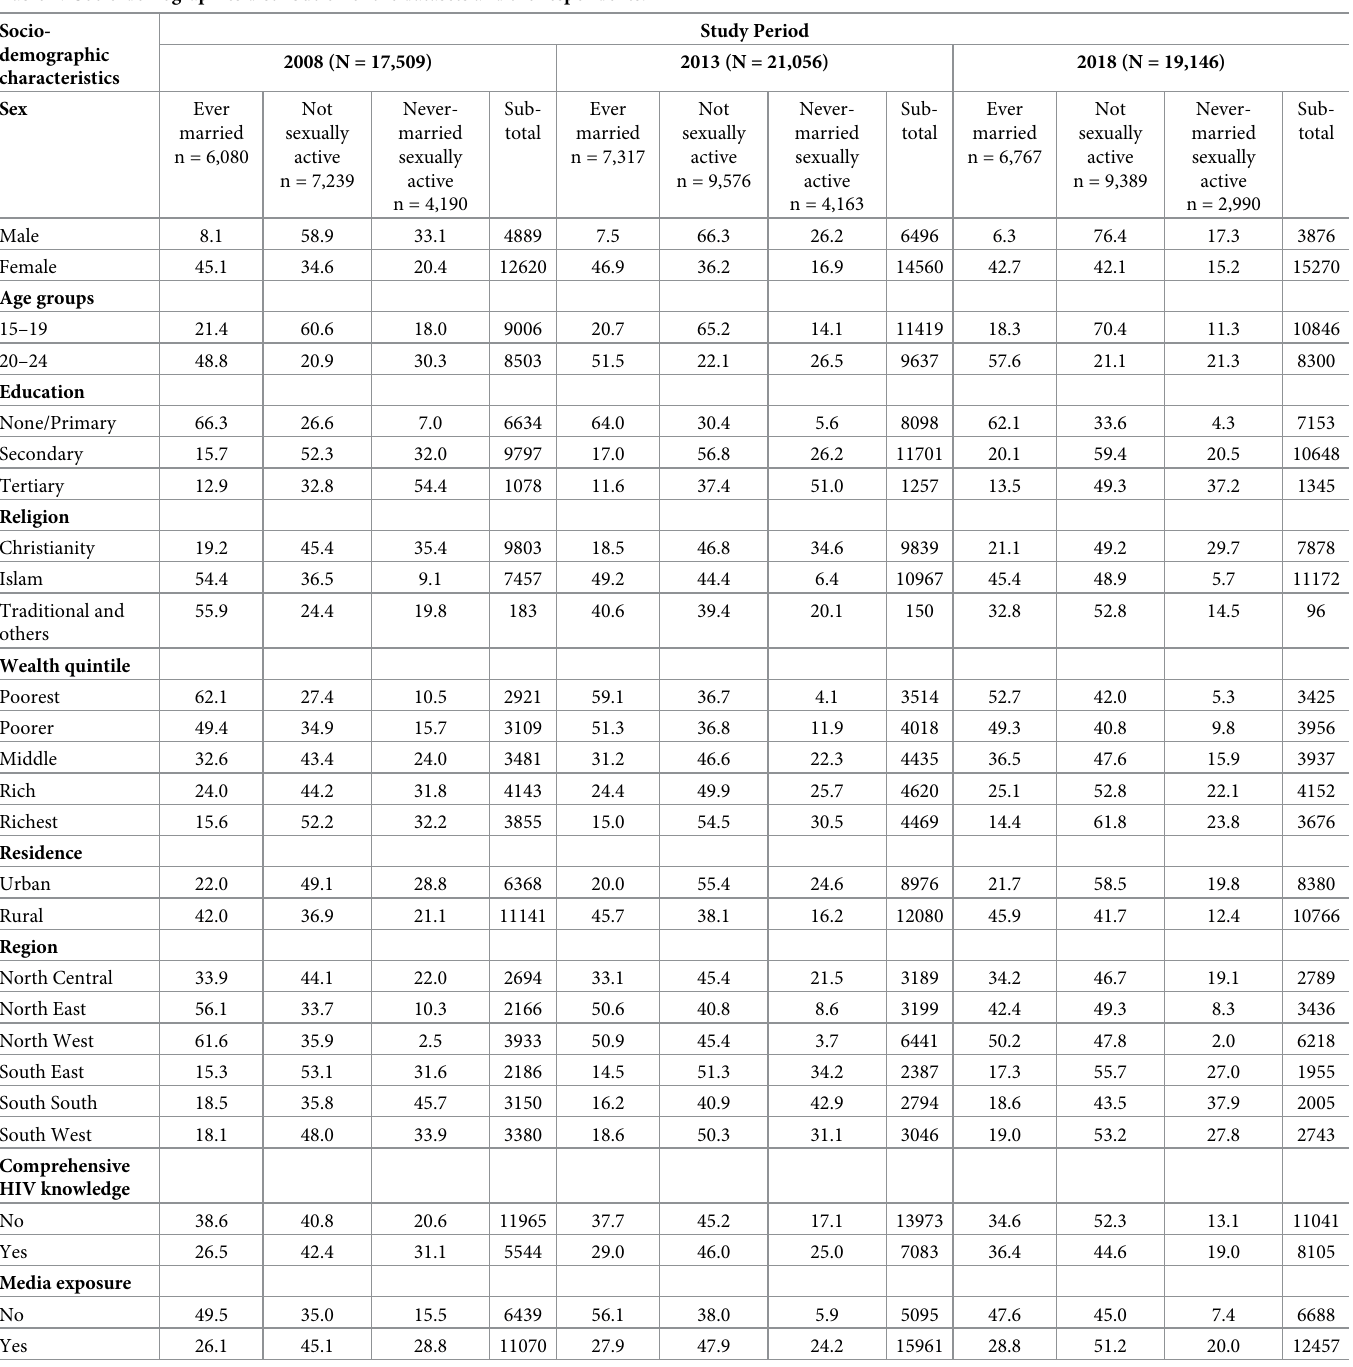
Table 2. Socio-demographics distribution of the datasets and the respondents. Socio-